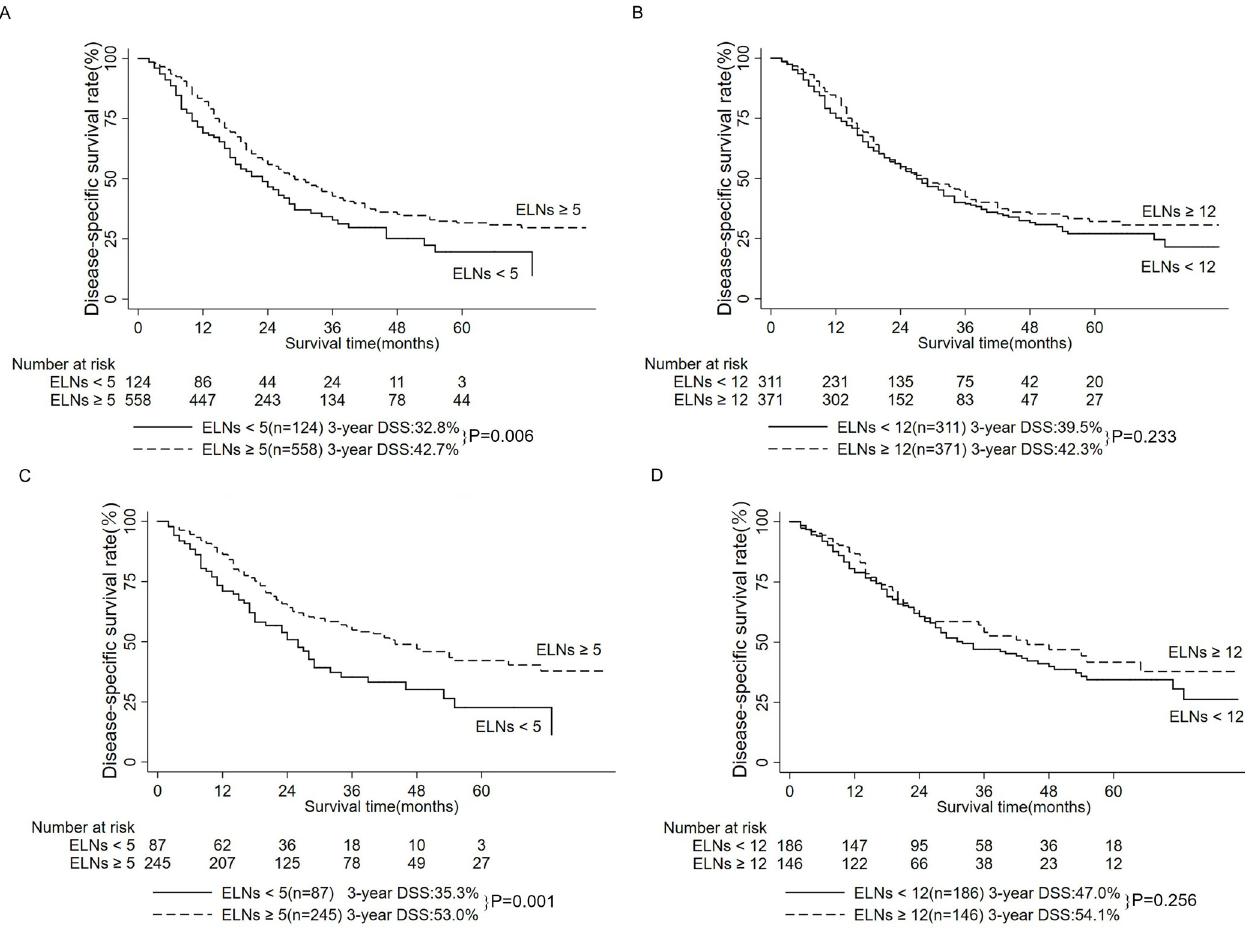
Fig 1. Survival analysis comparing the different numbers of ELNs. A: Survival analysis comparing the optimal cut-off value of the number of ELNs (5) in M0 cohort (n = 682). B: Survival analysis comparing the recommendation of the number of ELNs by the AJCC (12) in M0 cohort (n = 682). C: Survival analysis comparing the optimal cut-off value of the number of ELNs (5) in N0M0 cohort (n = 332). D: Survival analysis comparing the recommendation of the number of ELNs by the AJCC (12) in N0M0 cohort (n = 332).